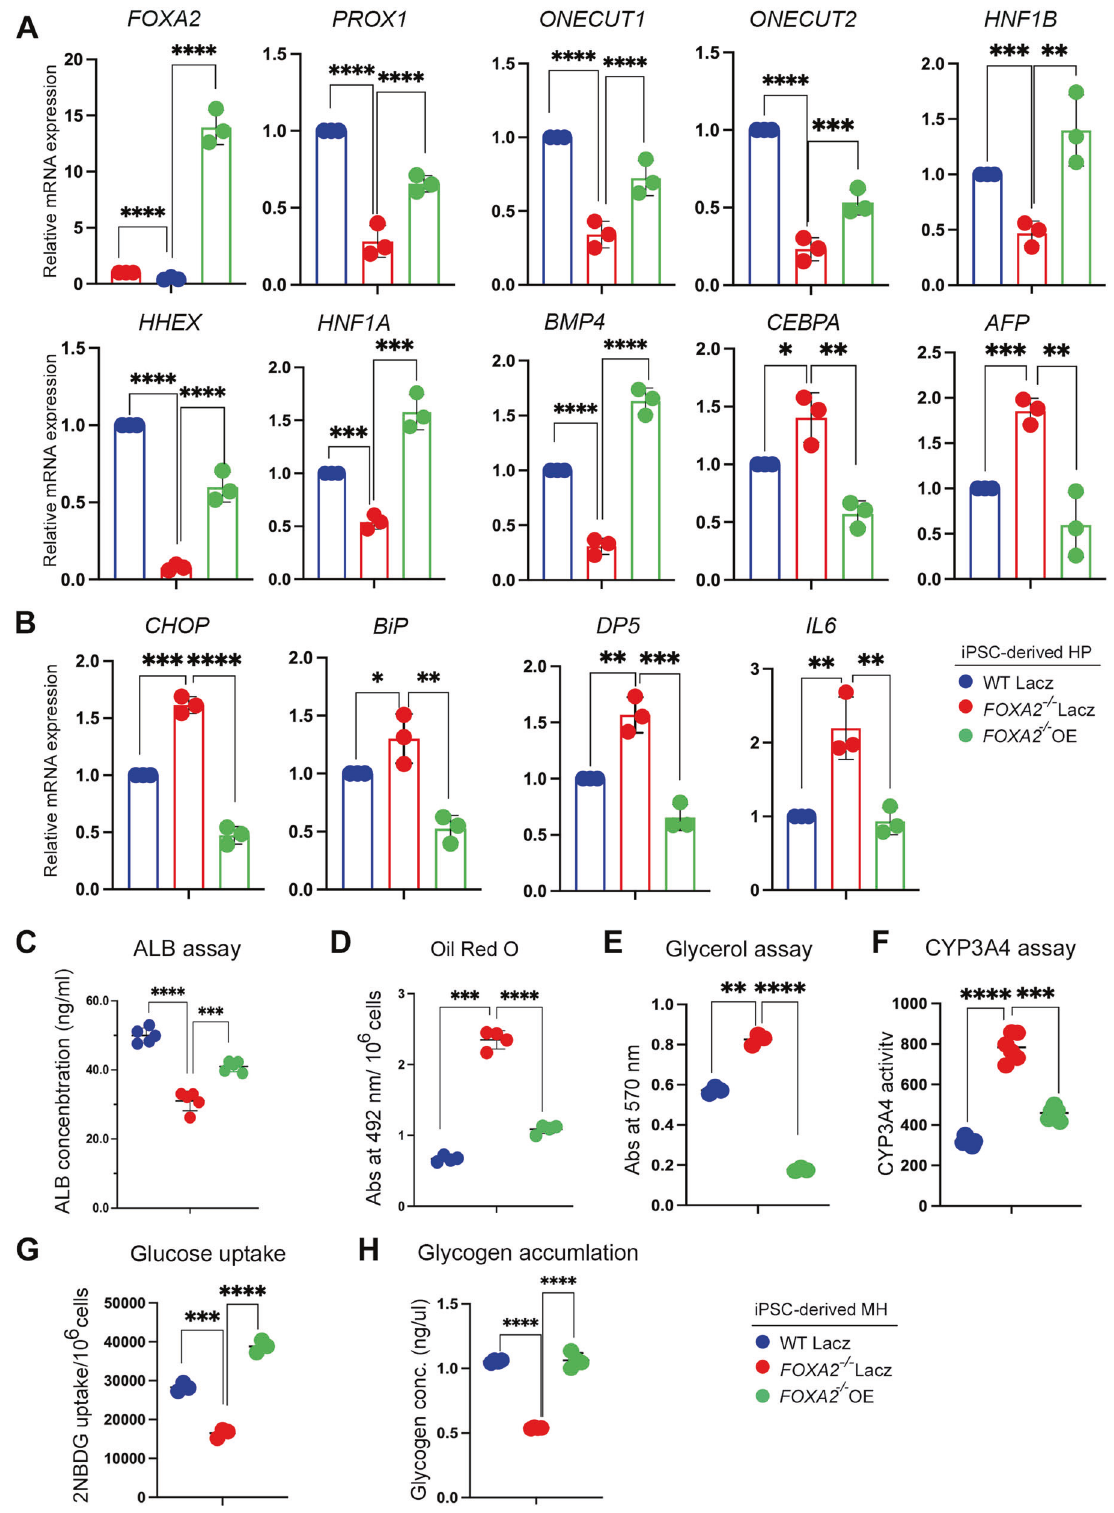
Fig. 7 FOXA2 overexpression rescues developmental and functional defects of iPSC-derived hepatocytes lacking FOXA2. A RT-qPCR analysis for the expression of hepatic progenitor markers, FOXA2 , PROX1, ONECUT1 , ONECUT1 , HNF1B , HHEX , HNF1A , BMP4 , CEBPA , and AFP in HP derived from FOXA2 − / − iPSCs and WT-iPSCs, 48 h after FOXA2 overexpression ( n = 3). B RT-qPCR analysis for the expression of ER stress markers, CHOP , BiP, DP5 , and IL6 in HP derived from FOXA2 − / − iPSCs and WT-iPSCs, 48 h after FOXA2 overexpression ( n = 3). C ALBUMIN (ALB) ELISA assay showing ALB levels measured in culture media of mature hepatocytes (MH) derived from FOXA2 − / − iPSCs, transfected with FOXA2 plasmid or empty vector (Lacz) at hepatic progenitor stage ( n = 5). Quanti fi cation of Oil Red O staining ( D ) ( n = 4), glycerol levels ( n = 3) ( E ), CYP3A4 activity ( F ) ( n = 6), glucose uptake ( n = 3) ( G ), and glycogen accumulation n = 3) ( H ) in MH derived from FOXA2 − / − iPSCs and WT- iPSCs, transfected with FOXA2 plasmid or empty vector at HP stage. Data are represented as mean ± SD; * p < 0.05, ** p < 0.01, *** p < 0.001. Cell Death and Disease (2022)